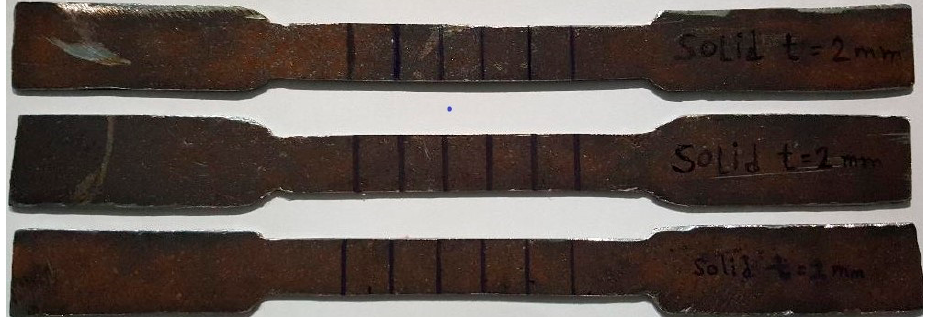
Figure 2. Standard tensile specimens of steel sheet.